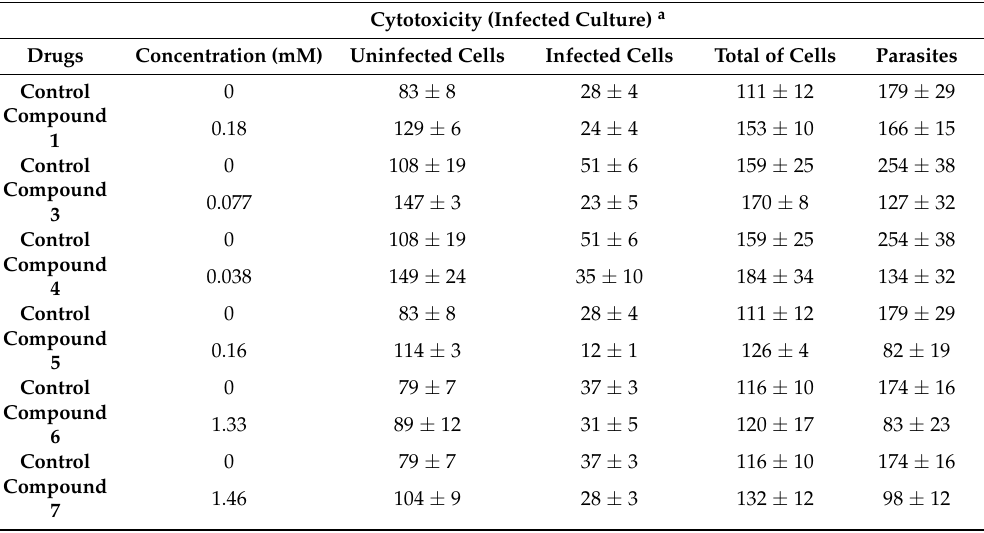
Table 2. Effect of compounds 1 and 3 – 7 on cultures of LLC-MK2 cells infected and multiplication of T. gondii